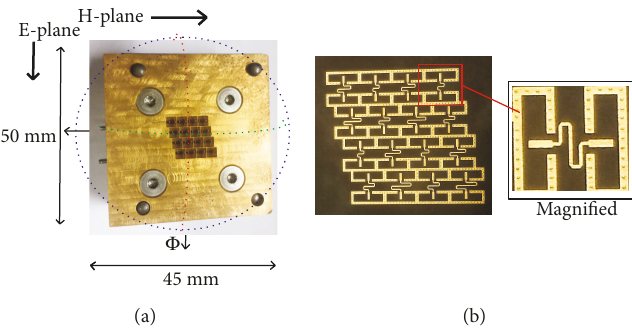
Figure 12: (a) The assembled antenna and (b) phase shifter printed-circuit boards at 72.5GHz.